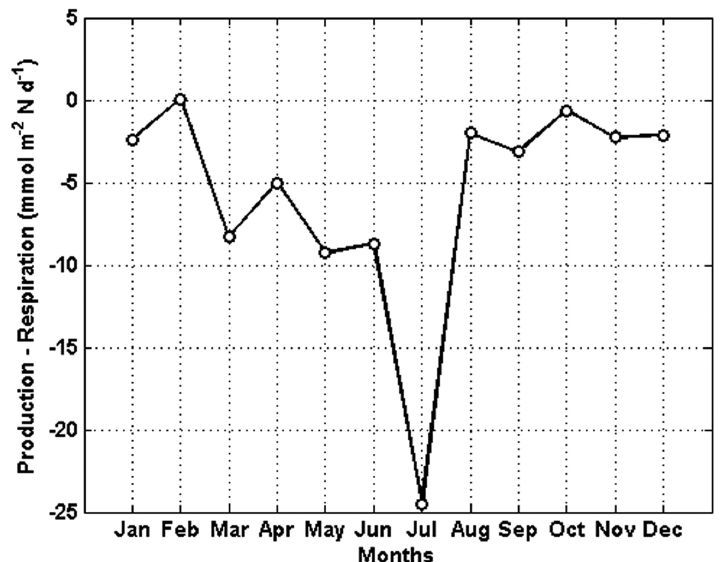
Fig. 8 – Monthly variation of N fixation and denitrification rates in the BJE. Negative and positive values indicate denitrification and fixation of nitrogen,